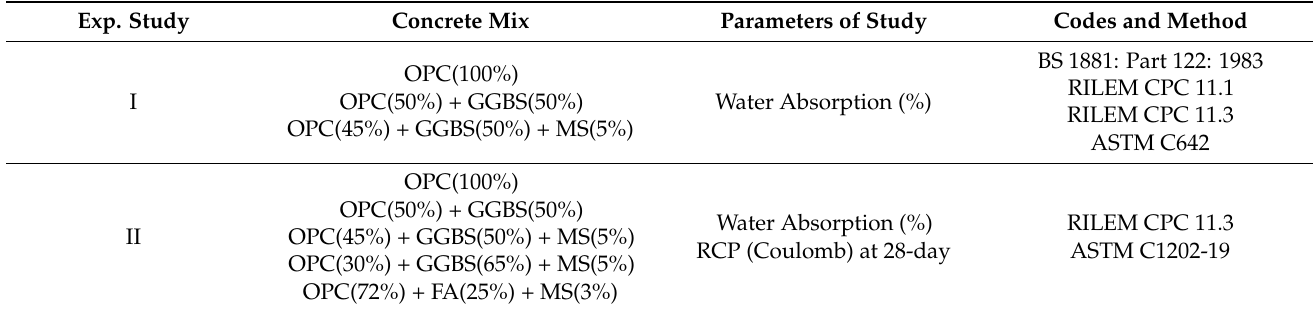
Table 2. Experimental study